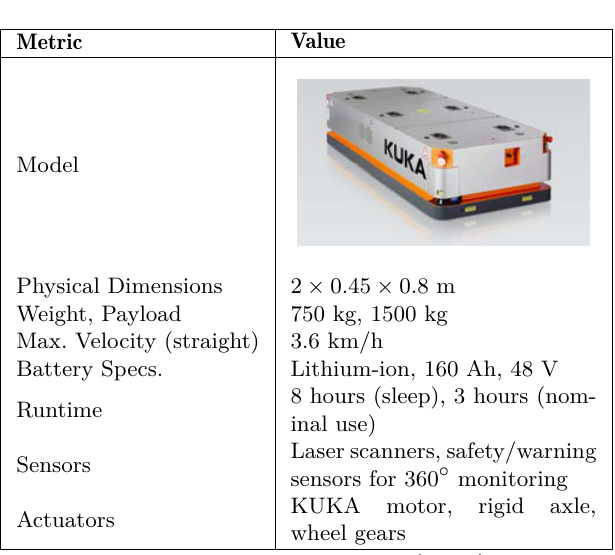
Table 2. KUKA mobile platform (KMP) 1500.